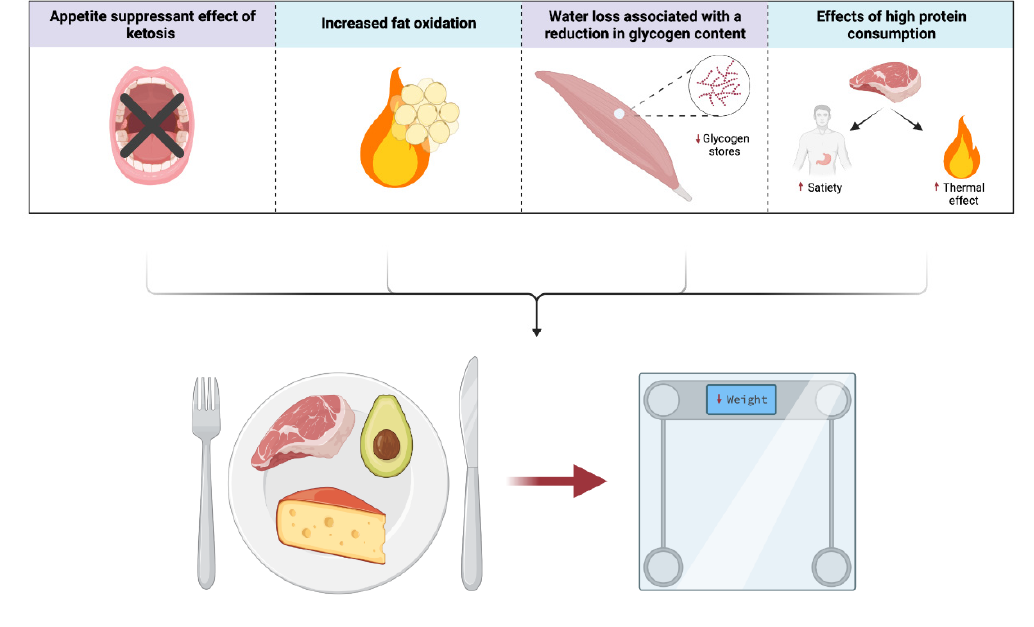
Figure 1. Summary of some potential mechanisms underlying the beneficial effects of ketogenic diets on weight loss.